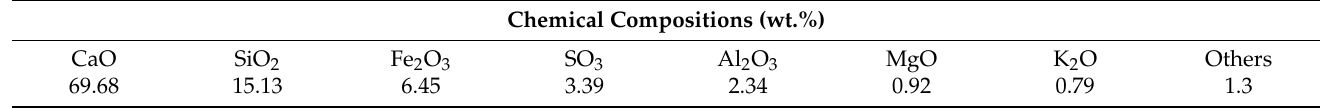
Table 1. Chemical composition of G class oil well